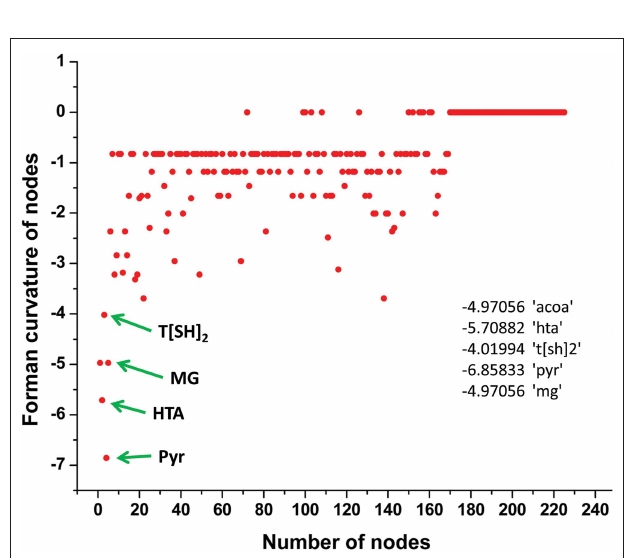
FIGURE 5 | Demonstration of Forman curvature of nodes in master model. Metabolites with high curvature values are labeled and pointed with green